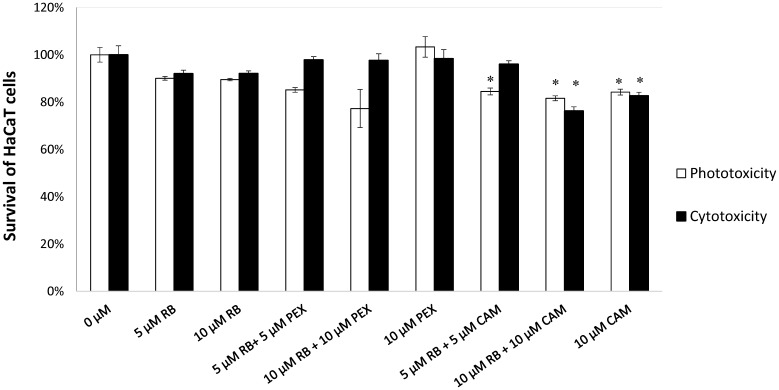
HaCaT cell viability assay. HaCaT cells were treated with compounds indicated on the X-axis. Reference cells (0 μM) constitute control conditions where no tested compounds were added. After incubation with particular tested compounds, cells were either subjected to irradiation (23 mW/cm2, 30 J/cm2) represented by white bars (Phototoxicity) or kept in the dark for the same period of time (gray bars, Cytotoxicity). Each result is a mean ± SD of a mean. Significance at respective p-values is marked with asterisks (∗p < 0.05) with respect to reference cells (0 μM).